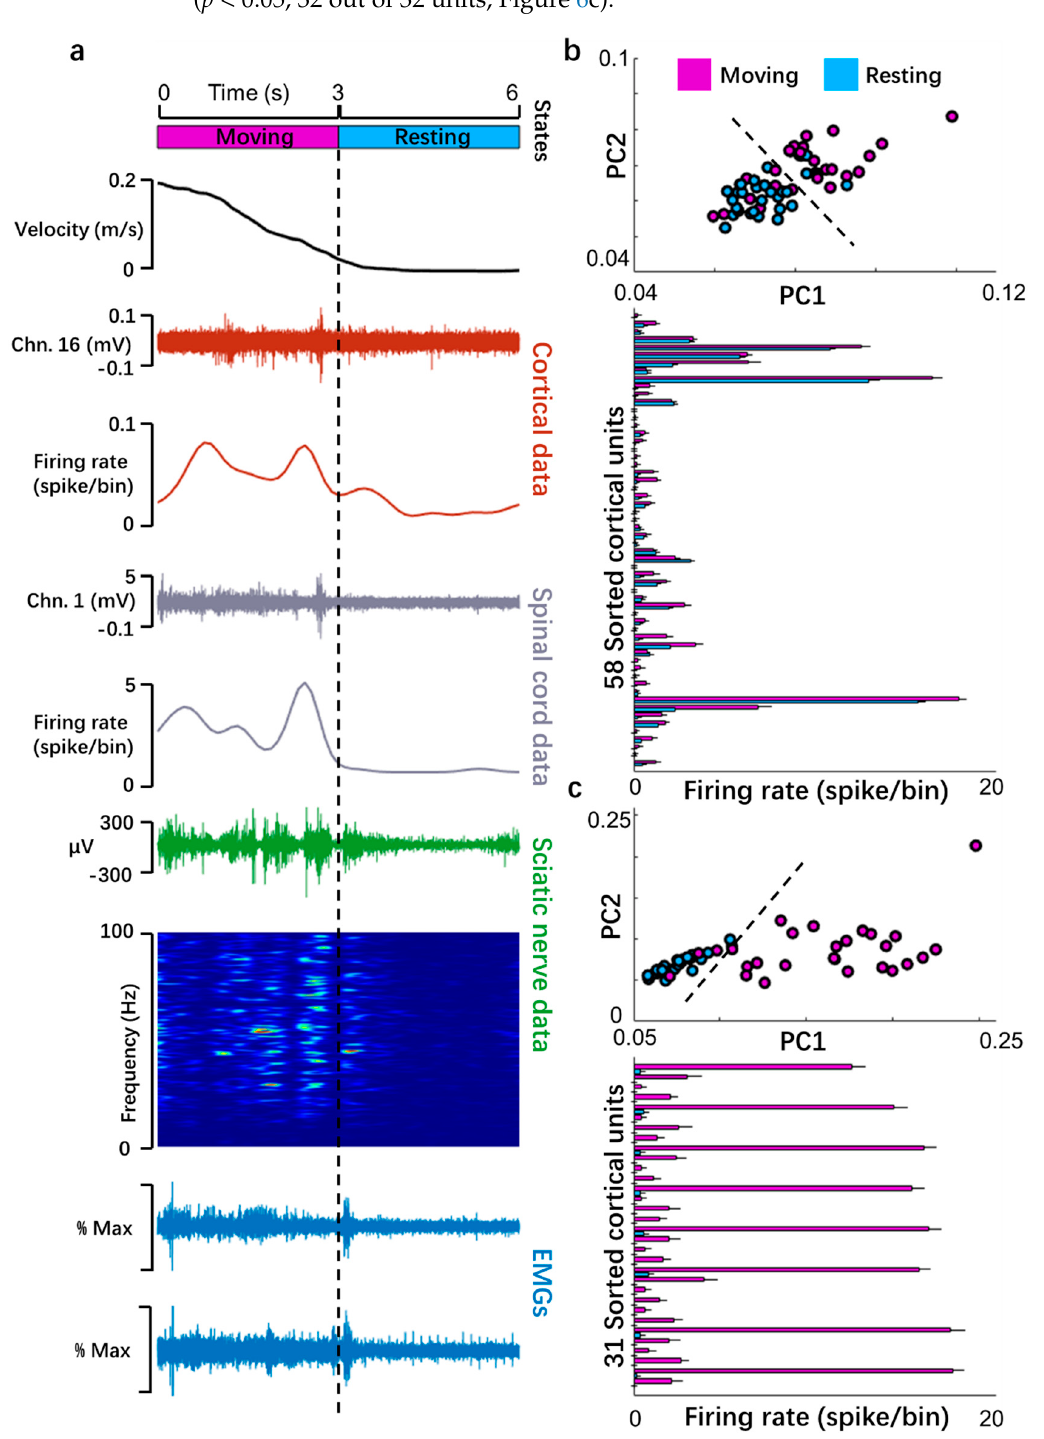
Figure 6. Sample data of long-term recording from a rat in an open field. ( a ) Sample data from 6-second moving-to-rest transition. From top: velocity of trunk movement; continuous signal and firing rate of a channel in motor cortex in spike/bin, where bin = 0.1 s; continuous signal and firing rate of a spinal cord channel; continuous signal and spectrograms of sciatic nerve; EMGs of rectus femoralis and semitendinosus muscles. ( b ) PCs and firing rate of cortical neuronal assemblies. Top: 2D PCA space of the 3 s data of the two states clearly indicating that it can be divided into two groups relying on principal components of cortical signals. Bottom: Comparison of firing rate of well-sorted units. ( c ) PCs and firing rate of spinal cord channels.